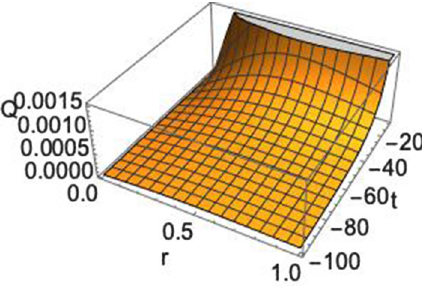
Fig. 3 Heat flow as a function of the radial and temporal coordinates